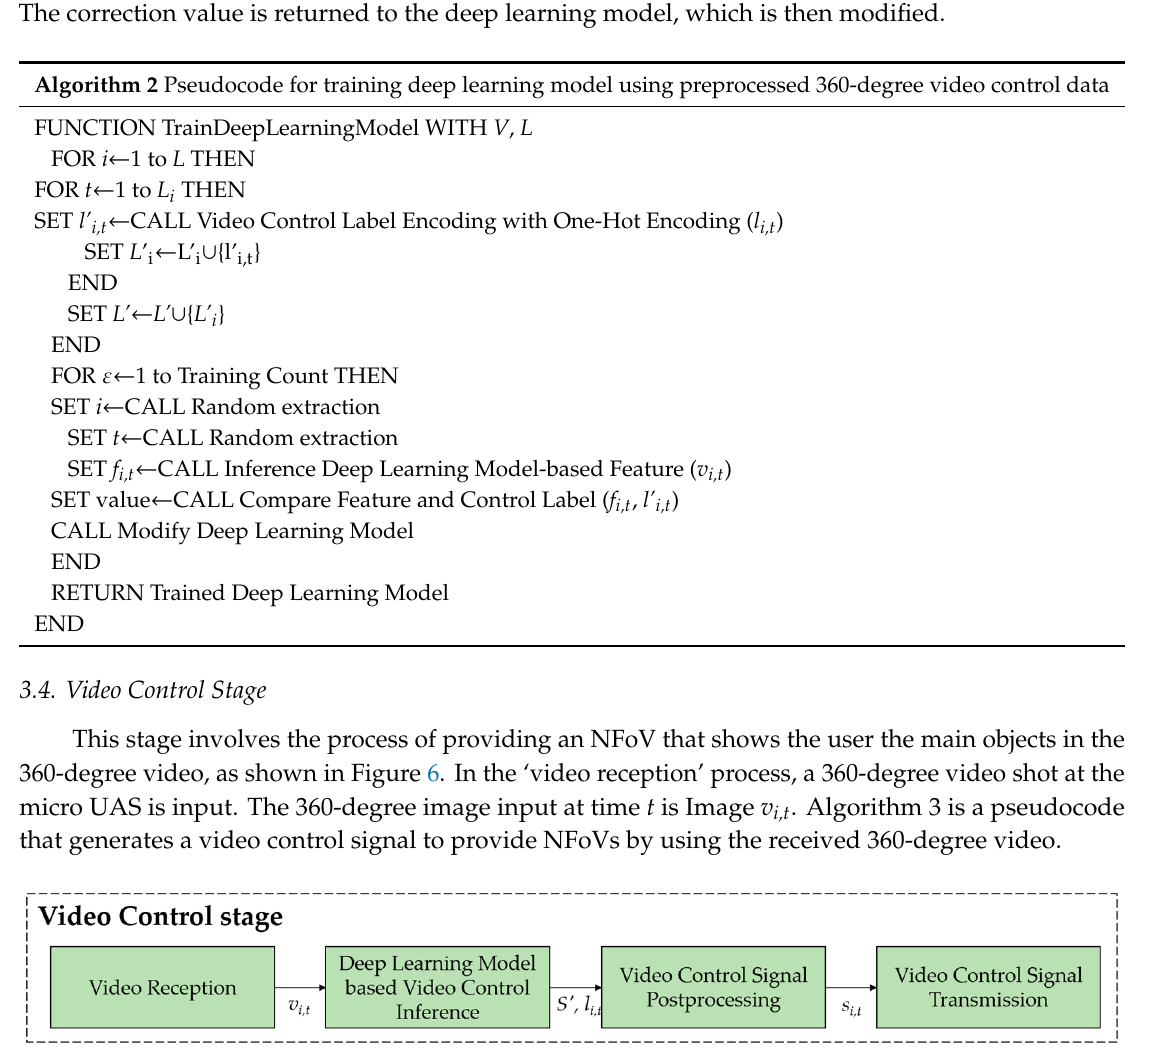
Figure 6. Process of generating NFoV based on a deep learning model that is based on end-to-end control of 360-degree video.